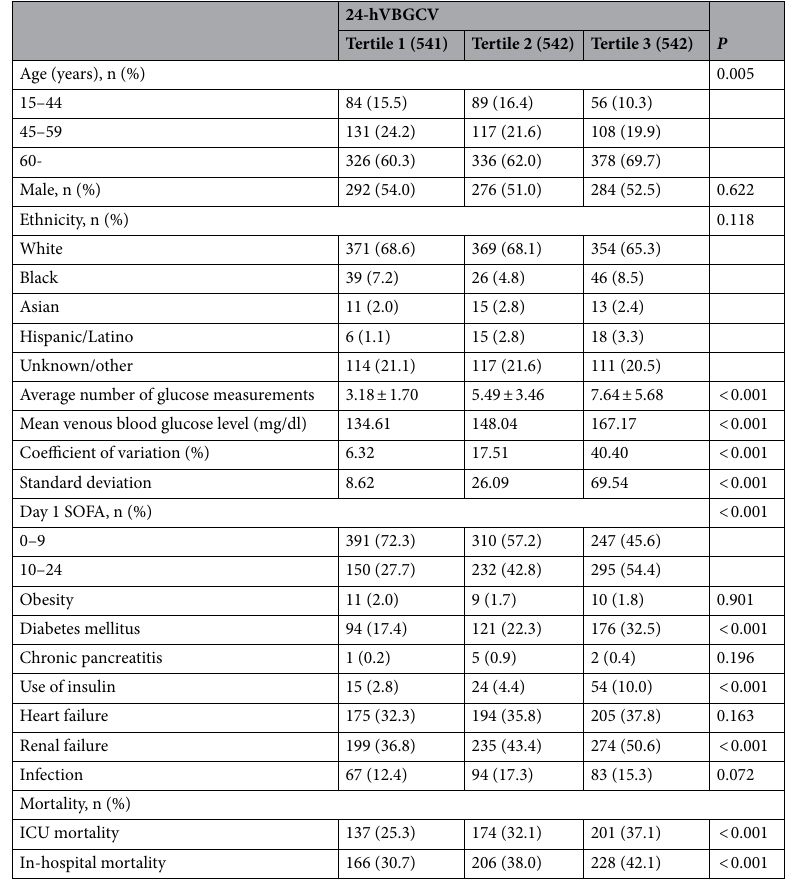
Table 1. Characteristics of the study subjects. 24-hVBGCV coefficient of variation of 24-h venous blood glucose, SOFA sequential organ failure assessment, ICU intensive care unit.